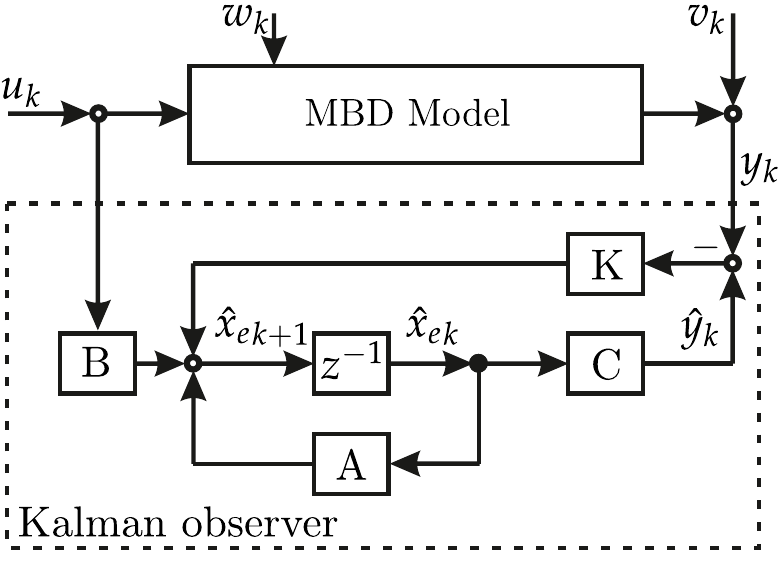
Figure 4. Schematic diagram of the dynamic system observed by the Kalman Filter